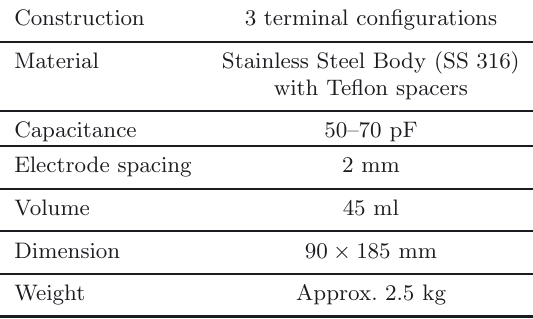
Table 3. Specification of Oil Test Cell.